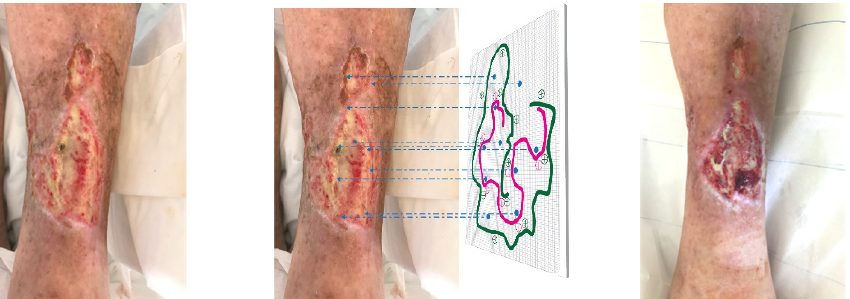
Figure 2. Left panel: Severe ulcers of the man’s leg, middle panel: Schematic application of a composite membrane consisting of a scaffold impregnated with self-associated macromolecules of chitosan (green) and high-molar-mass hyaluronan (purple) with a molecularly dispersed wound healing active medical principle (blue, a proper MTA), right panel: Result of a few-day treatment of the patient’s ulcers. Adapted with permission from ref. [75].